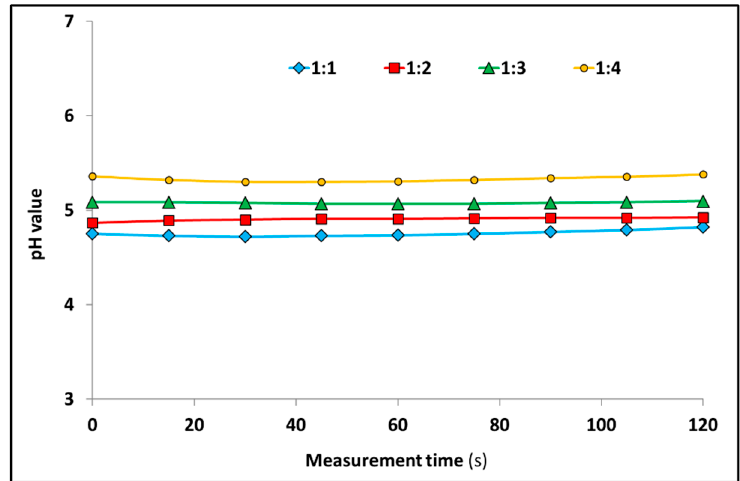
Figure 4. The pH values of wood with different moisture contents .